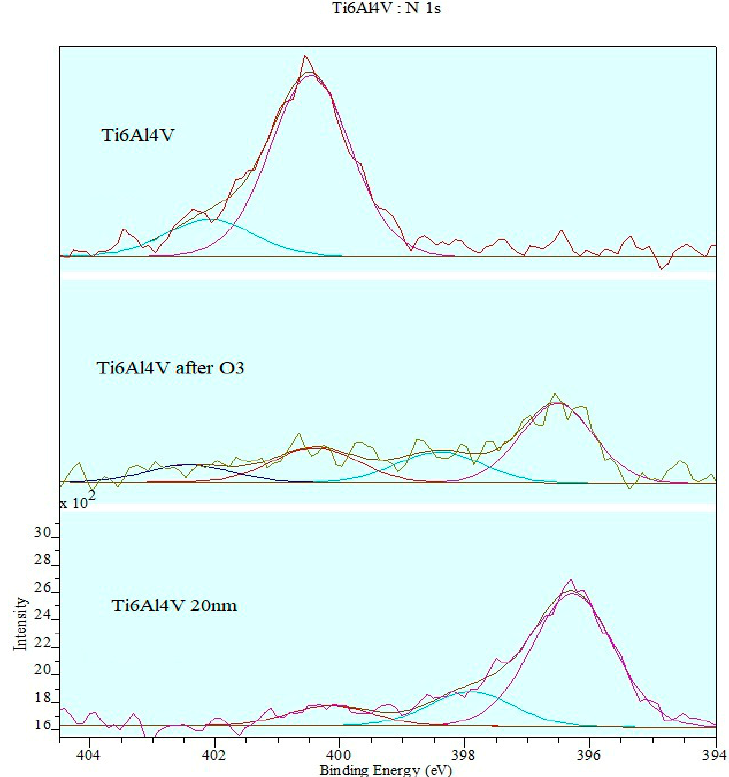
Figure 12. XPS spectrum of photoelectrons in titanium alloy sample.